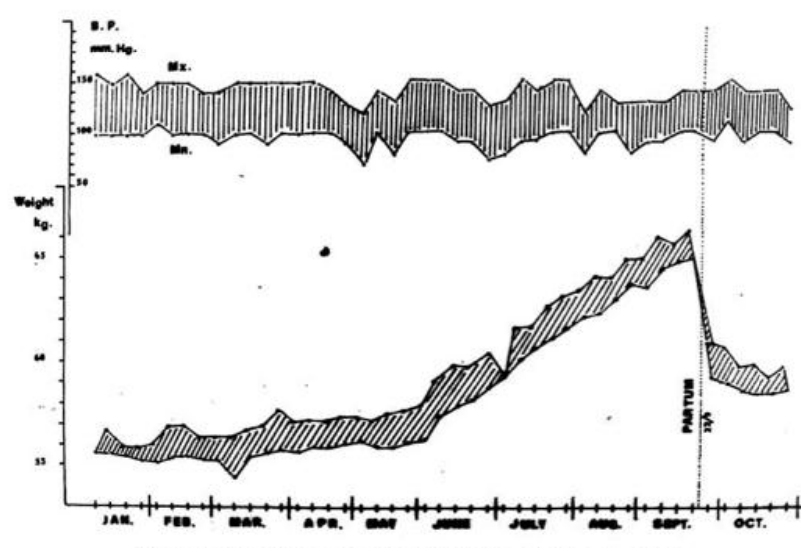
Figure 1. Weight gain during pregnancy on dialysis, from Confortini et al. [1] (Reproduced with permission from